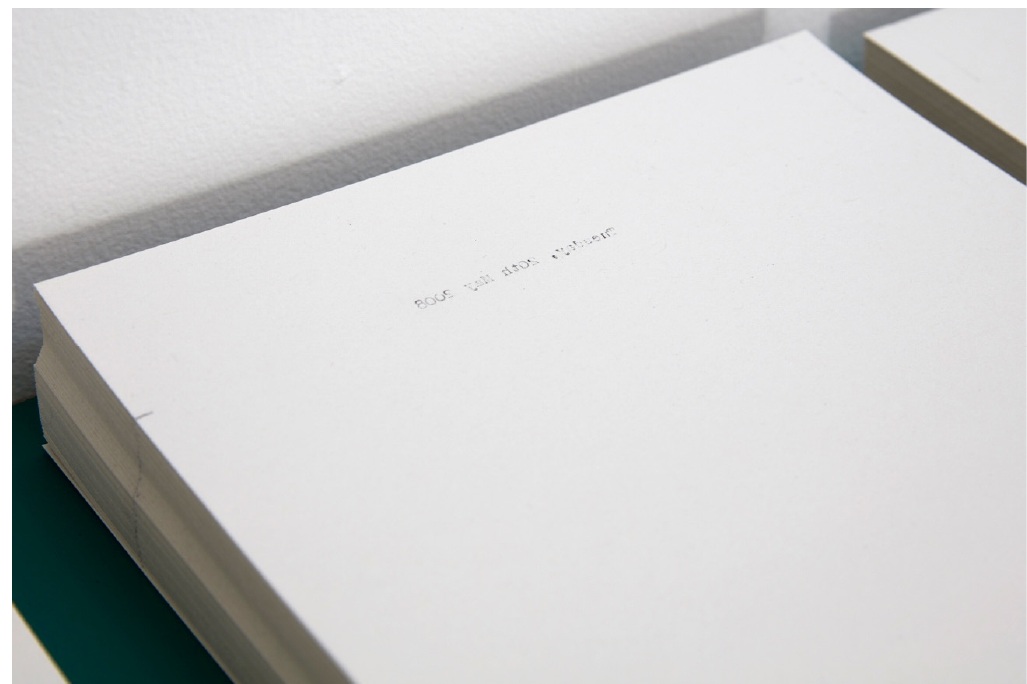
Figure 7. The days we’ve been together , 2018. Detail of back of page, showing scoring of paper by typewriter. Typewriter marks on paper, dimensions variable. Collection of the artist.